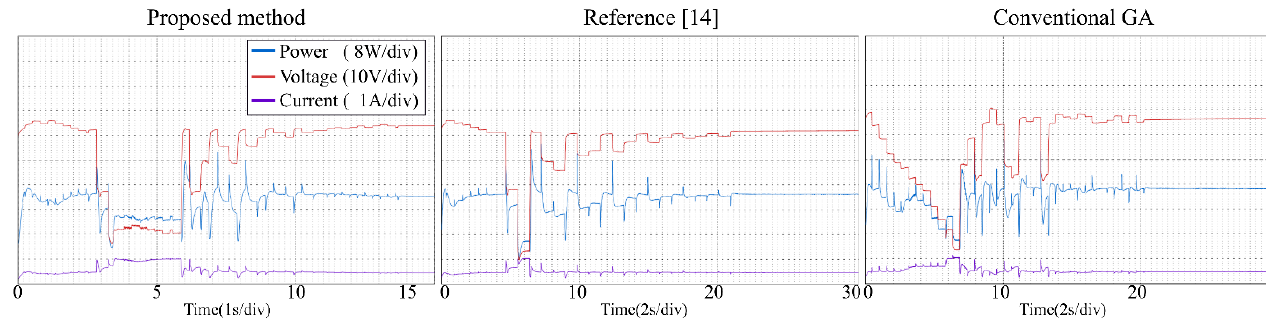
Figure 17. Tracking process—Pattern 5.